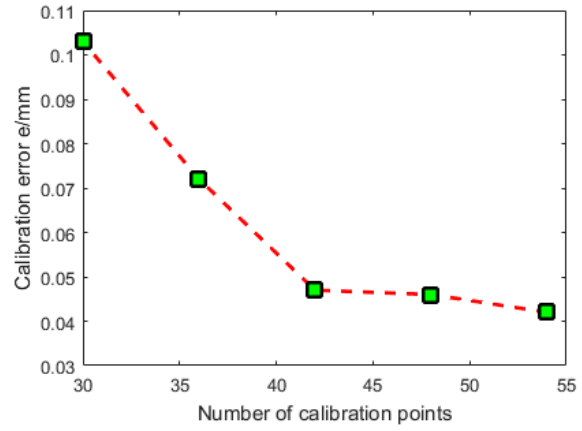
Figure 15. Relationship between number of calibration points and calibration error.